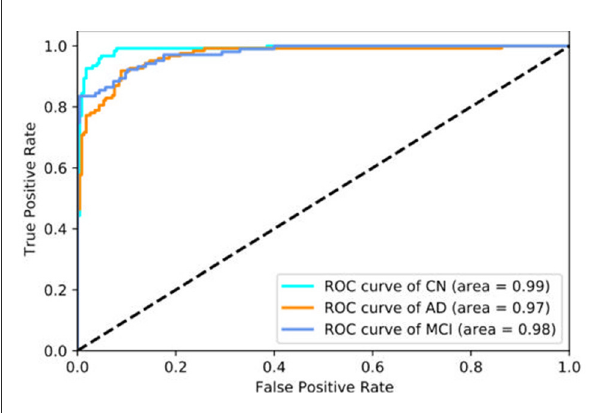
FIGURE4 ROC curve of our method tested on the ADNI data set. The ROC curve labeled AD represents the model’s performance in distinguishing AD vs. all other classes, the other curves represent the equivalent objective. The AUC is larger for CN than for the other classes, which indicates that our model can distinguish healthy subjects from patients with AD/MCI more successfully than other